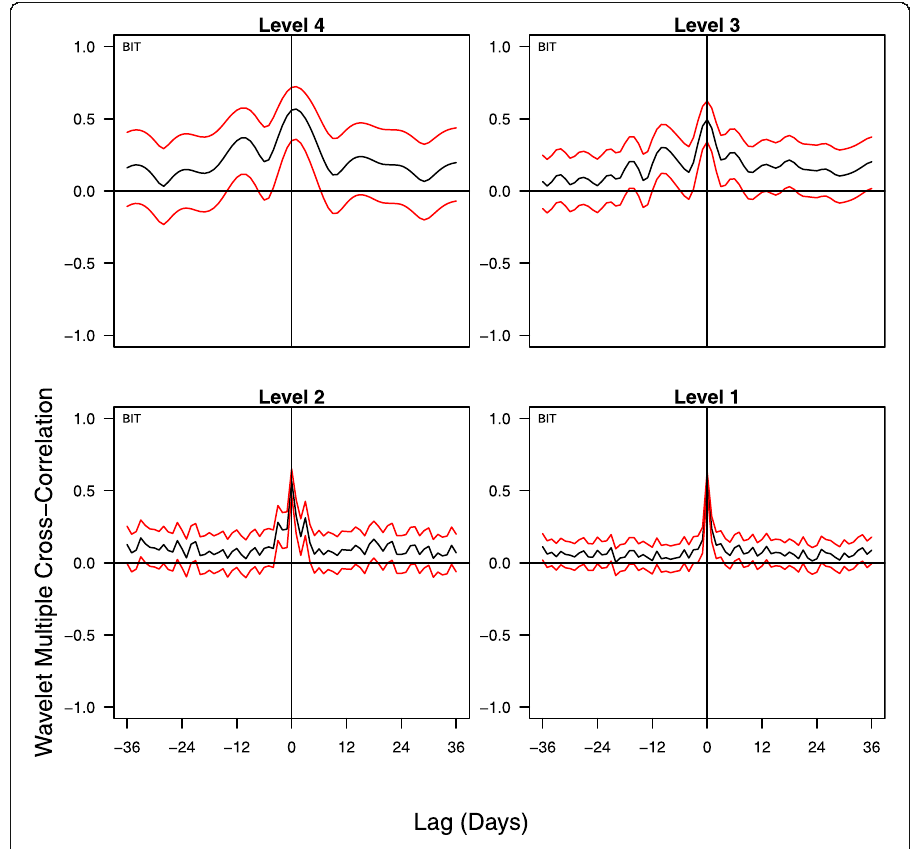
Fig. 3 Wavelet Multiple Cross Correlation of Crypto Currency